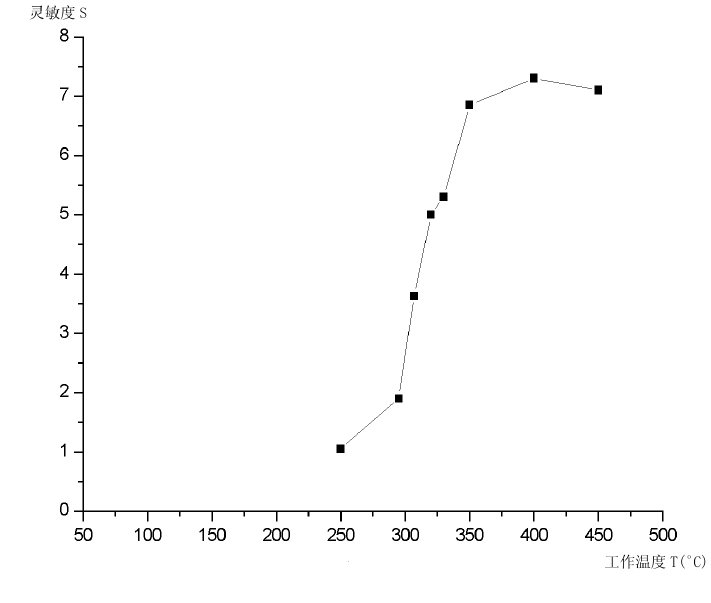
Figure 7. Relationships between gas sensitivity and working temperature of